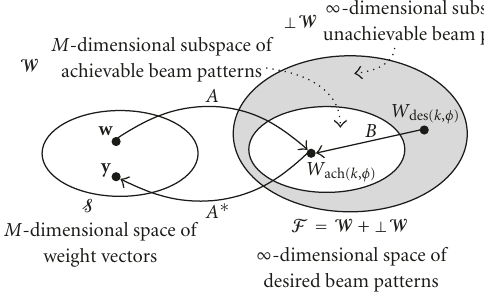
Figure 2: The relationships between spaces and